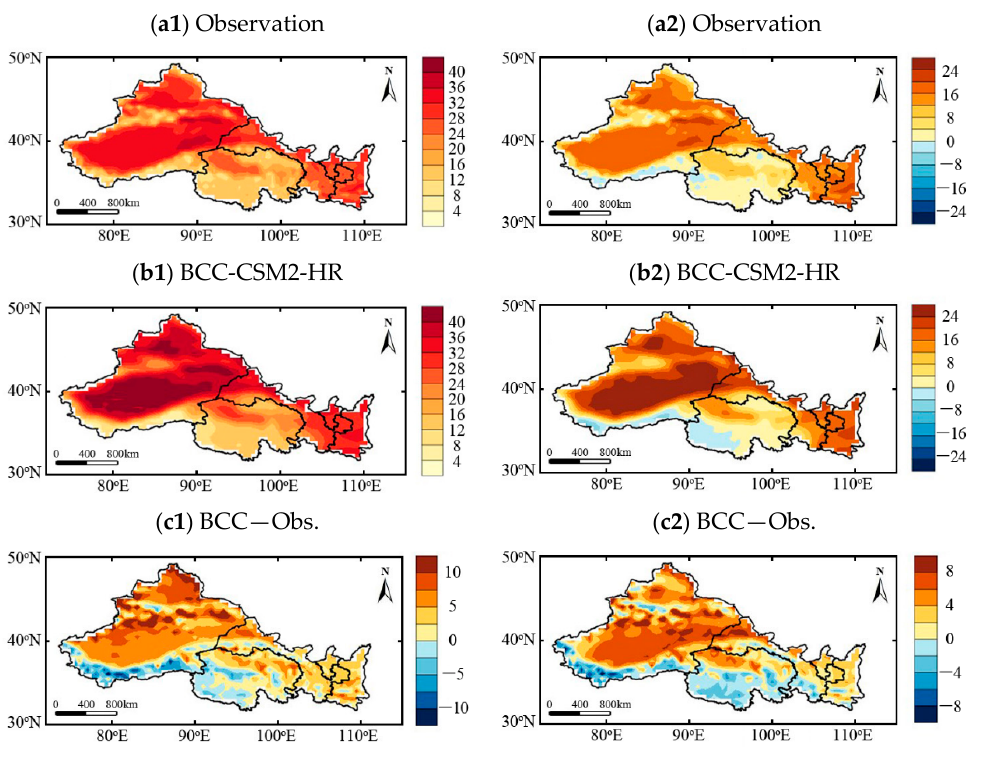
Figure 4. Spatial distribution of TXx ( left ) and TNx ( right ) over Northwest China during 1961–2014: observations, the values simulated by the BCC-CSM2-HR, and the difference between them. Unit: °C .